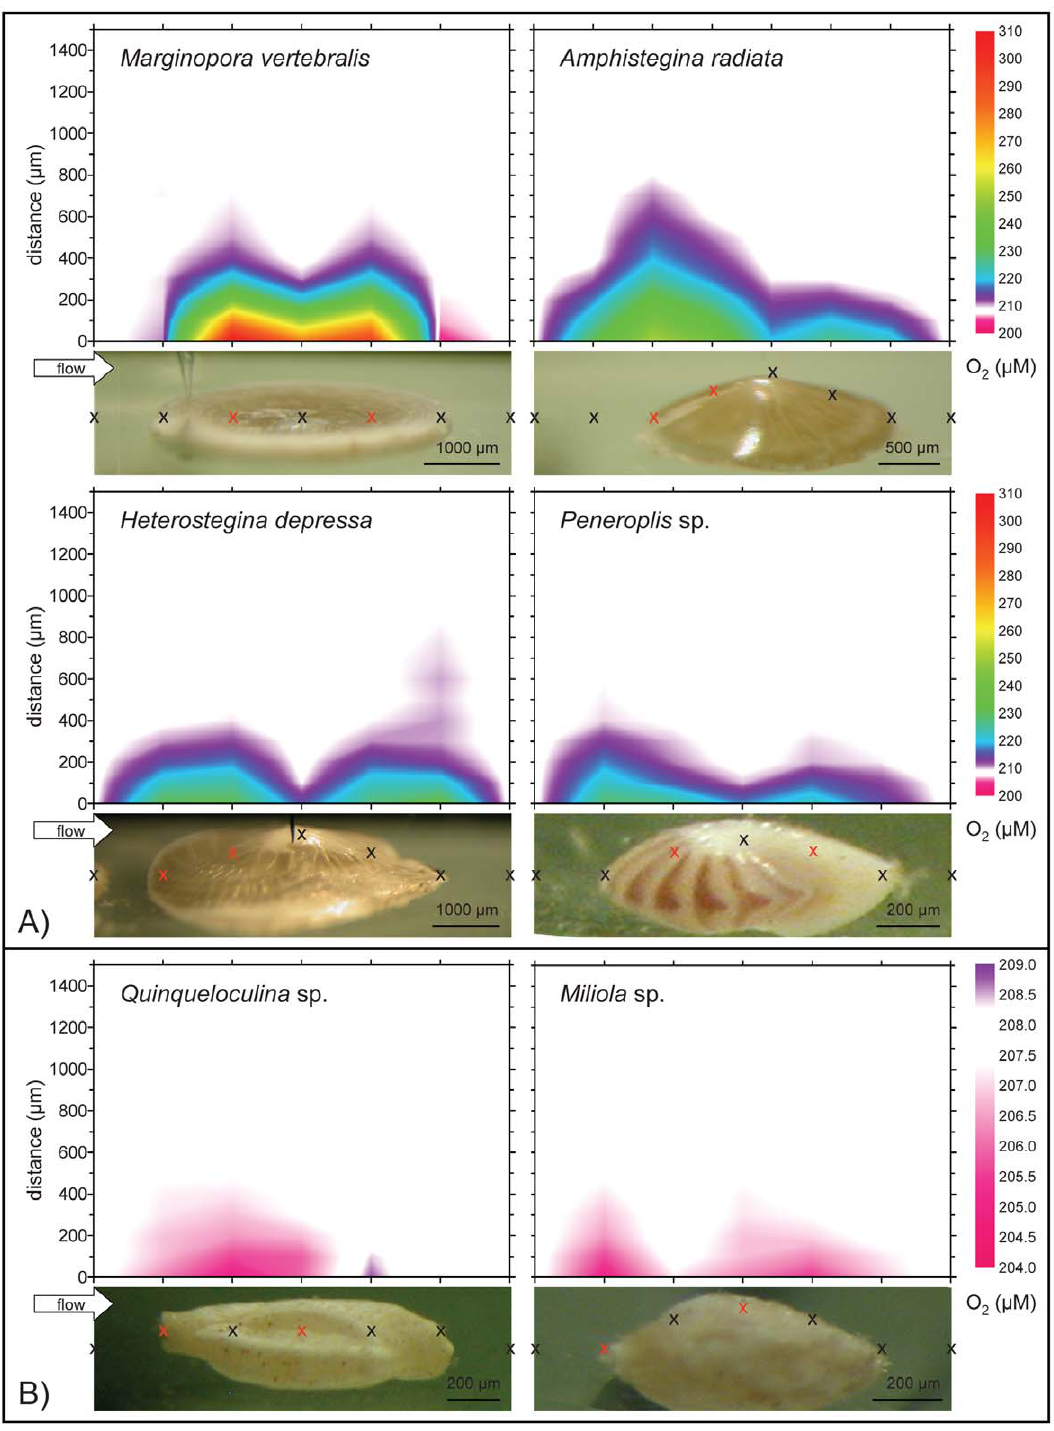
Figure 1. Microenvironmental O 2 heterogeneity at a pCO 2 of 432 m atm, 30 m mol photons m 2 2 s 2 1 light, and 0.5 cm s 2 1 water flow across foraminiferal shell surfaces. Data derived from fine-scale microsensor profiles at the points indicated by the crosses. Red crosses indicate the measurement positions (n=2–4) used for the calculation of means per individual. Note the different contour scales between A) photosymbiotic and B) symbiont-free species. doi:10.1371/journal.pone.0050010.g001 To illustrate the effect of zero flow (i.e. static culture) conditions 432 m atm (pH 8.22), 30 m mol photons m 2 2 s 2 1 under mean on pH microenvironments, individuals of Marginopora vertebralis turbulent flow conditions (0.5 cm s 2 1 ) and consecutively after flow were pH profiled at the same position on the calcite shell at was turned off after 5, 10, 20, 30, 40, 50, 60, 90 and 100 min and